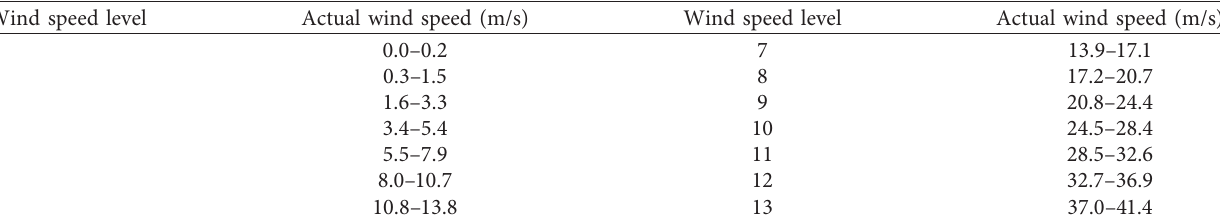
Figure 7: Comparison of PM 2.5 concentration at the Olympic Sports Center monitoring site under different time scales. Table 4: Wind level classification according to wind